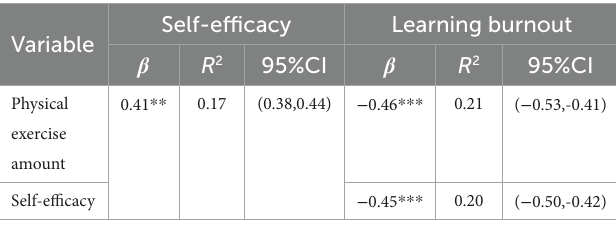
TABLE 4 The linear regression analysis of physical exercise amount, self- efficacy, and learning